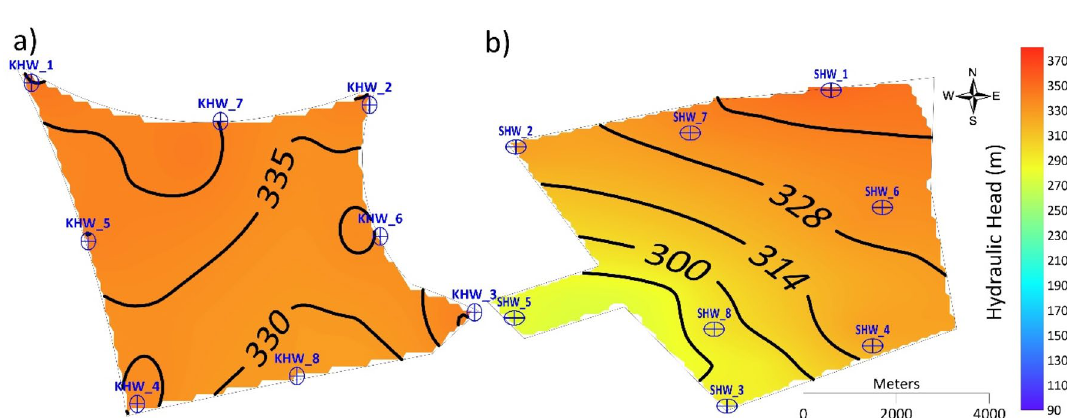
Figure 9. Simulated hydraulic head in 2030 for Scenario 3 at ( a ) Al-Khrair and ( b ) Al-Shuwaib